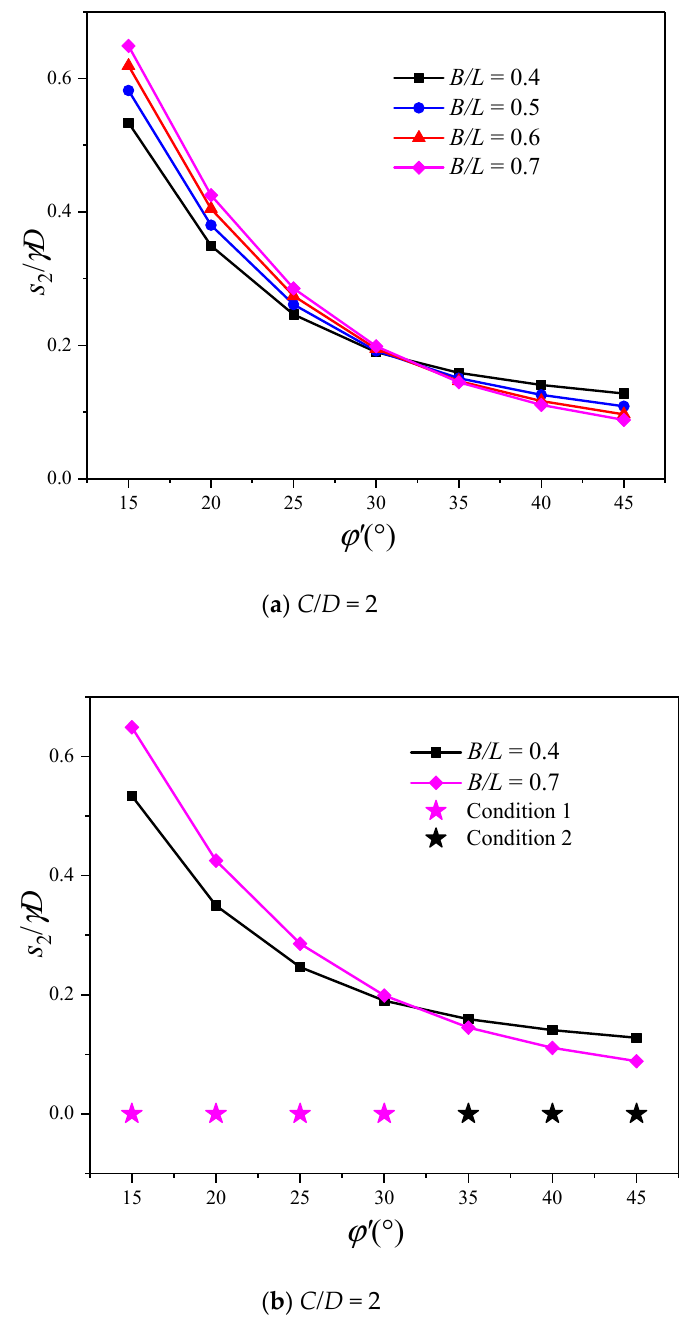
s D γ depending on ϕ′ . Figure 16. Variations in Figure 16. Variations in s 2 / γ D depending on ϕ (cid:48) 2